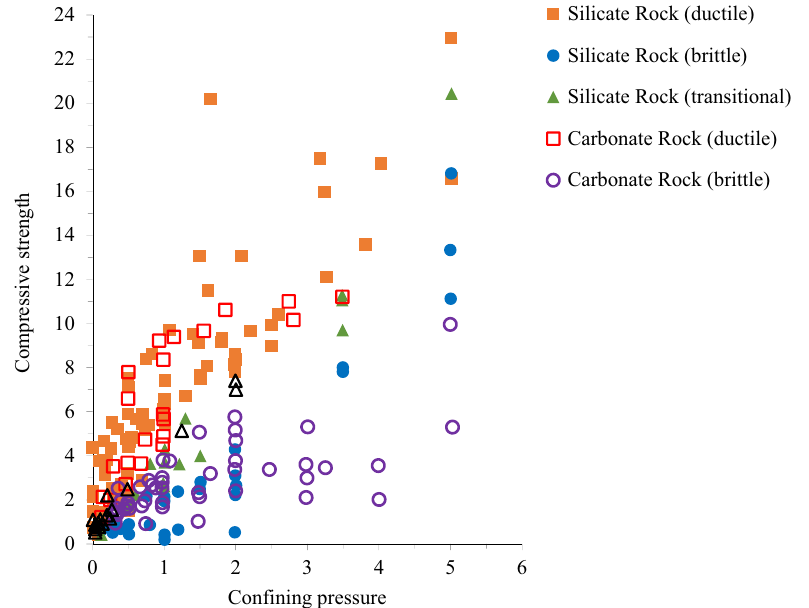
Figure 2. Failure behavior of rocks at various strength and pressure for silicate rocks and carbonate rocks.